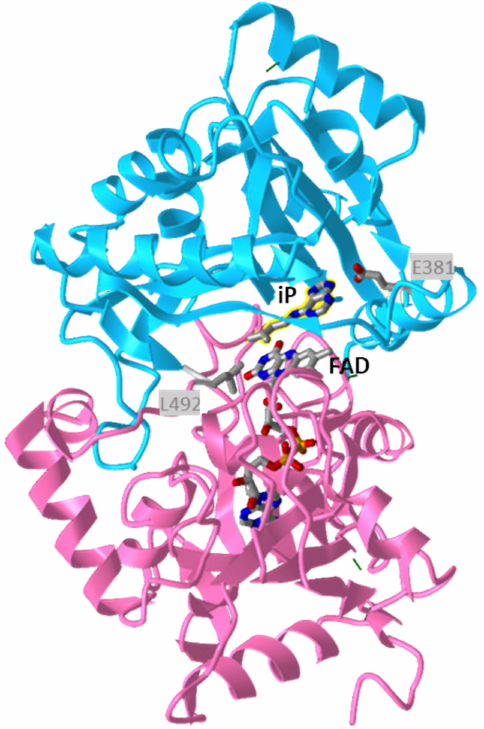
Figure 6. Structure of maize CKX (ZmCKX1) in complex with isopentenyladenine. The FAD-binding domain is shown in deep pink and the cytokinin-binding domain in deep sky blue. The FAD cofactor and iP substrate (highlighted in yellow) are shown, together with the Glu and Leu residues (E381 and L492, respectively), affecting the substrate specificity. The image was drawn by iCn3D structure viewer [50] using PDB coordinates 1W1Q